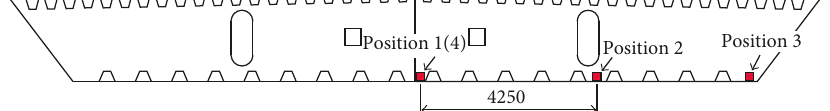
Figure 5: Cross section and explosive positions (unit: mm).